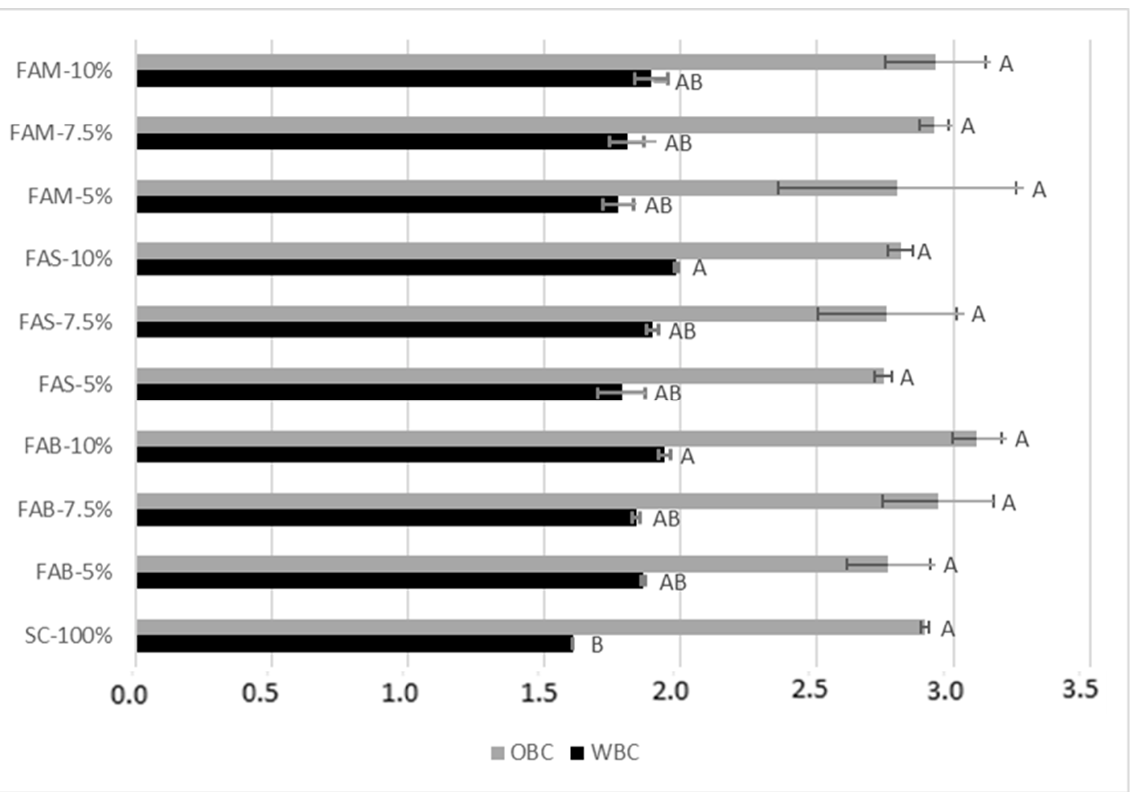
Figure 2. Water binding capacity (WBC; g water/g flour) and oil binding capacity (OBC; g oil/g flour) of re-milled semolina and of mixes prepared at increasing levels of replacement (5, 7.5, 10%) with flours from artichoke stems and bracts. SC-100% = re-milled semolina 100%, i.e., control; FAB = flour of artichoke bracts; FAS = flour of artichoke stems; FAM = flour of mixed artichoke bracts and stems. Different letters indicate a significant difference ( p ≤